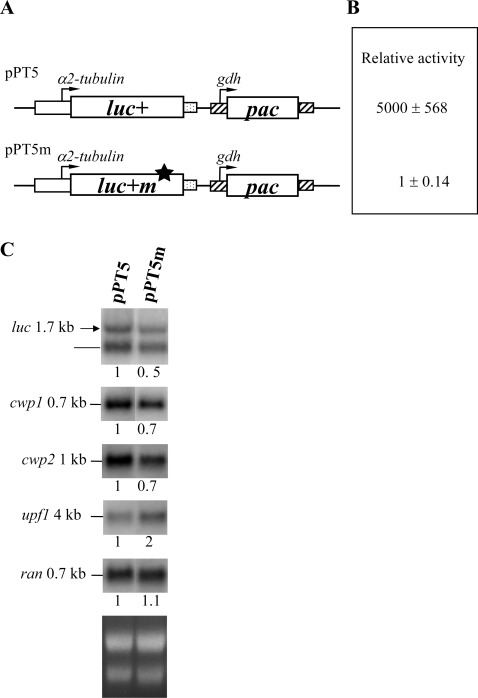
Down-regulation of the cwp genes in cells expressing the luciferase gene with a nonsense mutation.(A) Diagrams of the pPT5 and pPT5m plasmids. The pac gene (open box) is under the control of the 5′- and 3′-flanking regions of the gdh gene (striated box). The luciferase reporter gene (luc+, open box) is under the control of the 5′-flanking region of the α2-tubulin (open box) and the 3′-flanking region of the ran gene (dotted box), respectively. The arrows show the directions of gene transcription. Plasmids pPT5 and pPT5m encode a wild-type luciferase gene (luc+) with 550 amino acids and a luciferase mutant (luc+m) in which Leu 411 was mutated to a termination codon (marked by a star) and Asp 500 was mutated to Asn, respectively. (B) Nonsense mutation leads to a decrease of luciferase activity. After stable transfection with the pPT5 and pPT5m constructs, luciferase activity was measured in vegetative cells. The activity of pPT5 transfectants relative to pPT5m transfectants is presented. Values are shown as mean±standard error. (C) Down-regulation of the luciferase gene with a nonsense mutation. Total RNA blots made from vegetative transfectants were hybridized with specific gene probes as indicated (upper panels). Ribosomal RNA loading controls are in the bottom panel. Representative results are shown. Two different luciferase transcripts, a 1.7 kb full-length transcript (shown by an arrow) and a 1.2 kb transcript (shown by a line), were detected in the pPT5 and pPT5m transfectants. The numbers show the relative activity, which reflects expression relative to that in controls.